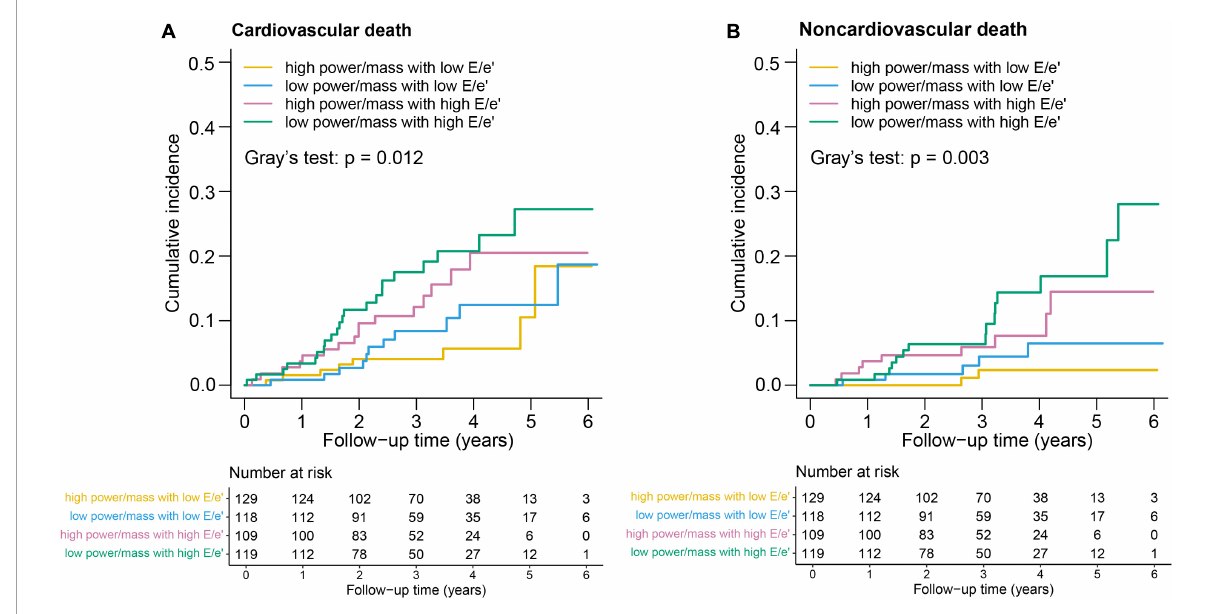
FIGURE2 Kaplan–Meier survival curves for (A) cardiovascular death and (B) noncardiovascular